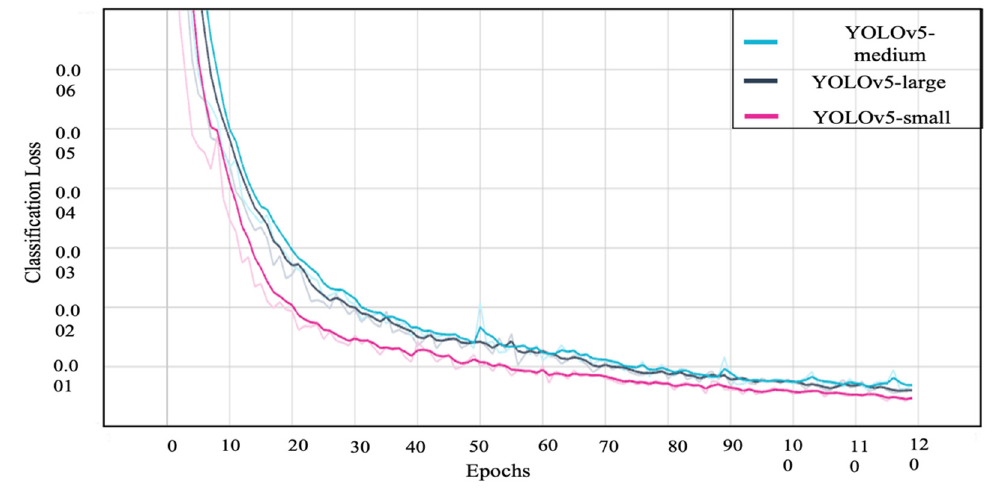
Figure 6. Training and classification loss of YOLOv5 models.